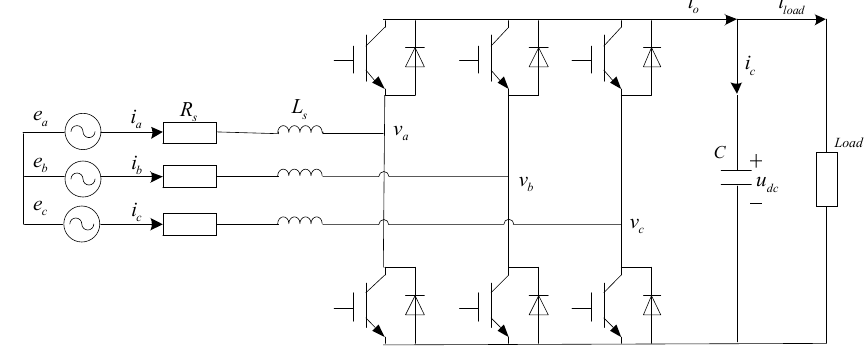
In the medium and low voltage small capacity DC distribution network, AC/DC con- verter usually adopts three-phase six pulse bridge rectifier circuit, and its circuit topology structure is shown in Figure 9.